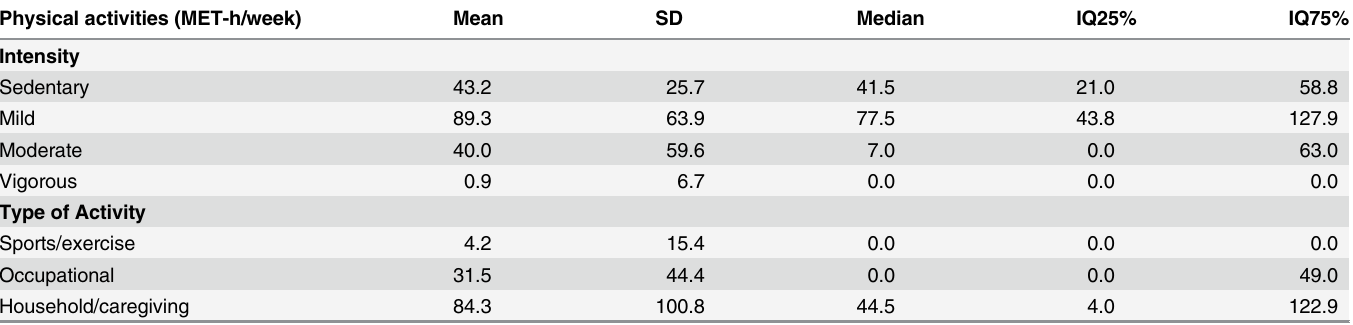
Table 2. Description of physical activity energy expenditure in MET-h/week during pregnancy, according to intensity and type of activity based on PPAQ. Physical activities